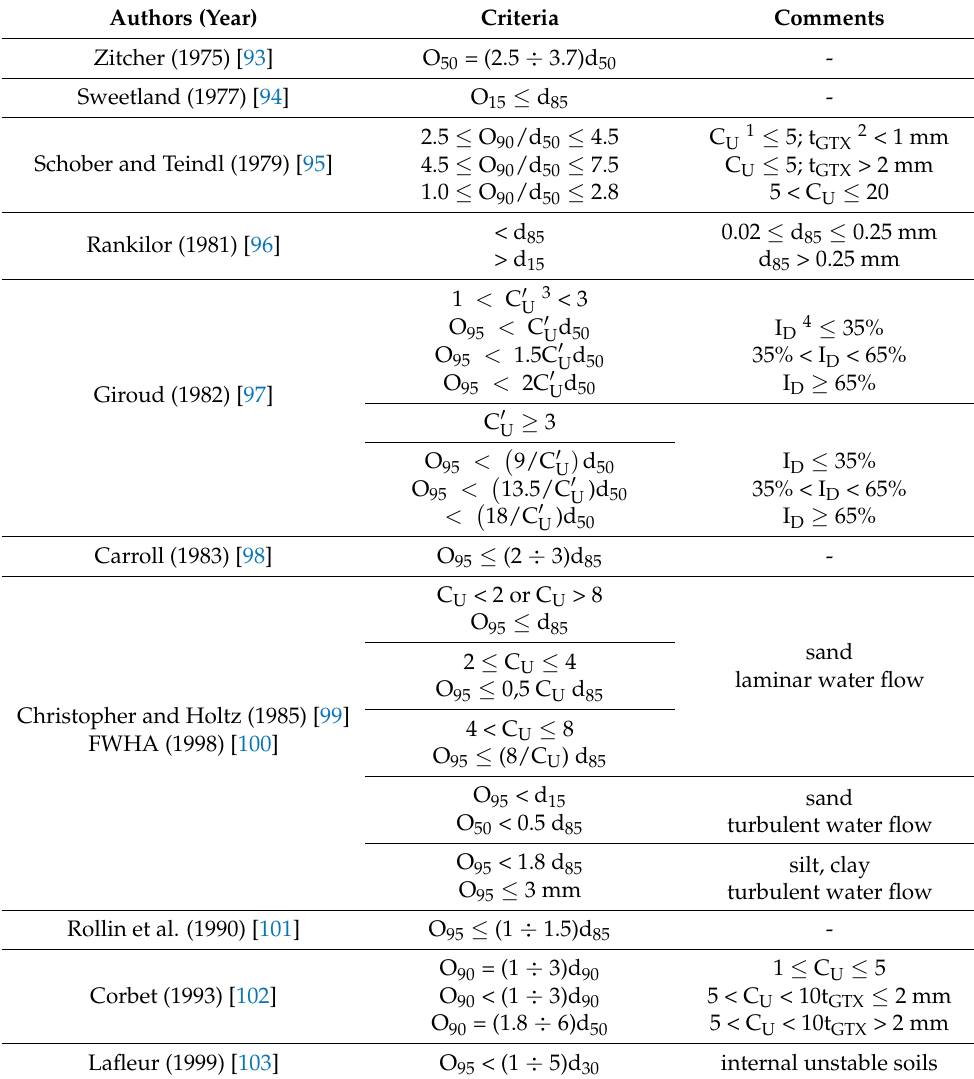
Table 5. Selected retention